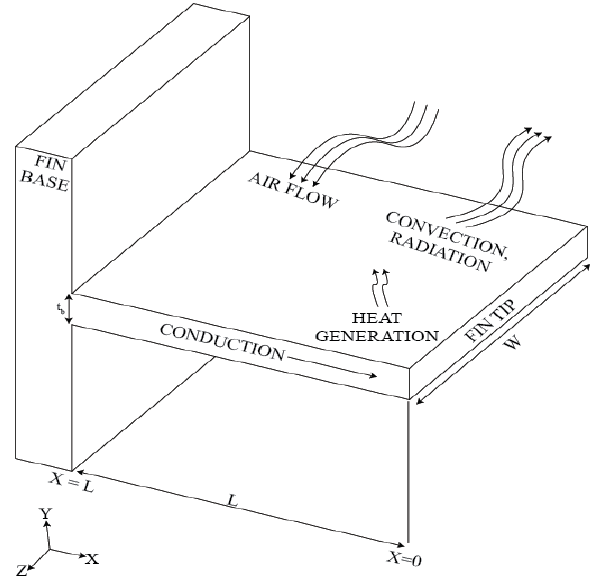
Figure 1. Representation of a rectangular fin.